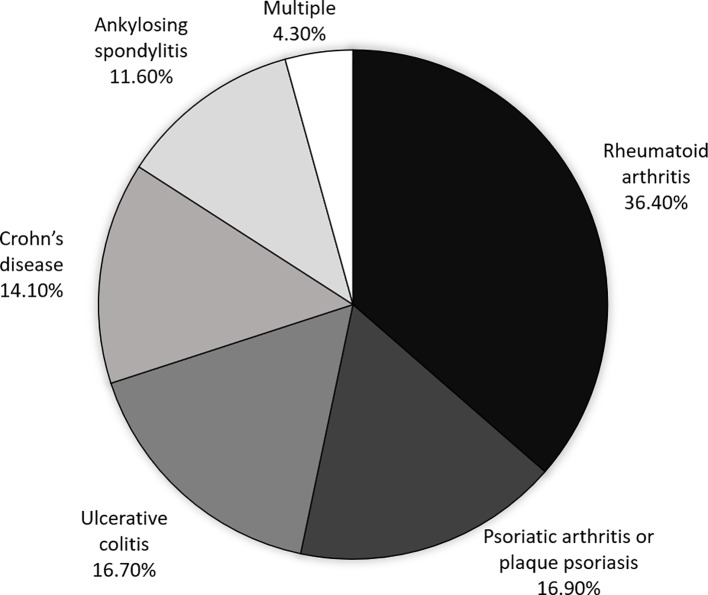
Infliximab indications in the cohort as a whole (n=325,319).